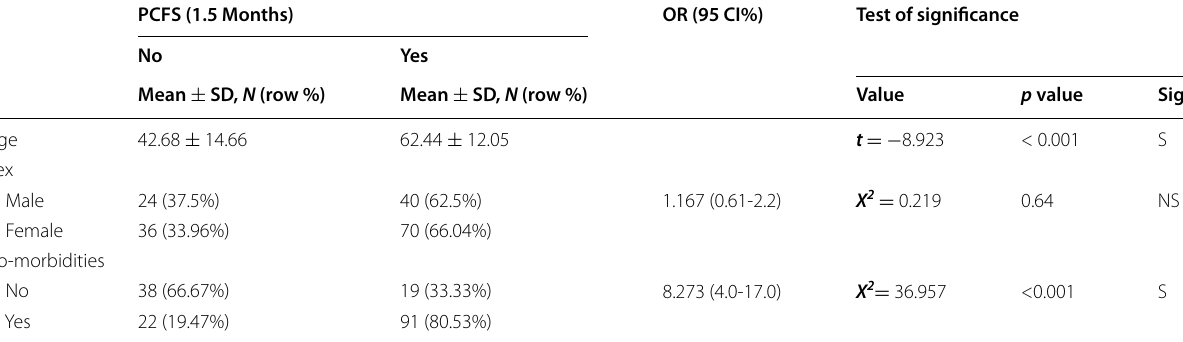
OR odd ratio, CI confidence interval, t student t test value, X 2 chi-square test value; statistical significance at p